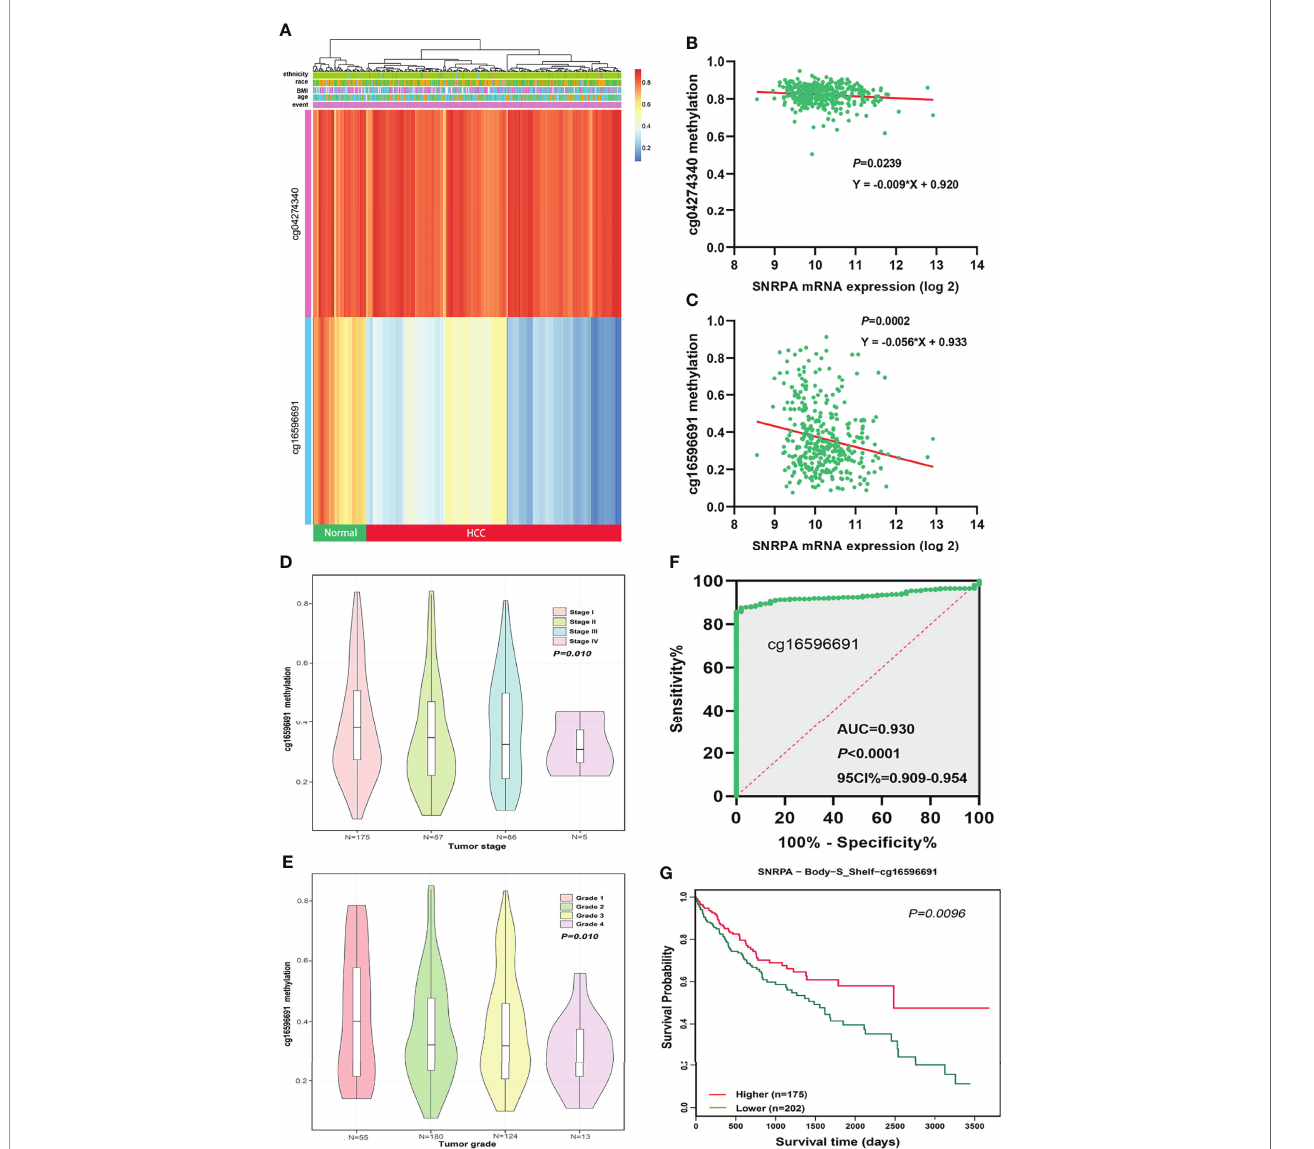
FIGURE 5 | Aberrant DNA methylation level contributed to dysregulation of SNRPA expression in HCC patients. (A) The SNRPA -related methylated CpG sites in HCC was shown in the heat map. (B, C) The correlation between SNRPA mRNA expression and cg04274340 (B) and cg16596691 (C) methylation status. (D, E) The methylation status of cg16596691 gradually decreased as the tumor stage (D) and grade level increased (E) . (F) The prognostic signi fi cance of the methylation status of cg16596691 for HCC was assessed by the ROC curve. (G) Hypomethylation of cg16596691 correlated with poorer OS in